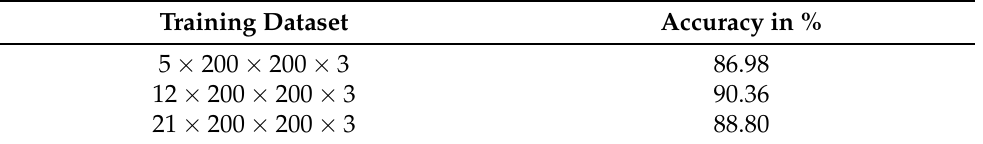
Table 6. Achieved accuracies of video classification on the test dataset, for datasets with different number of frames. Raw, mirror, noise and histogram datasets are used respectively.